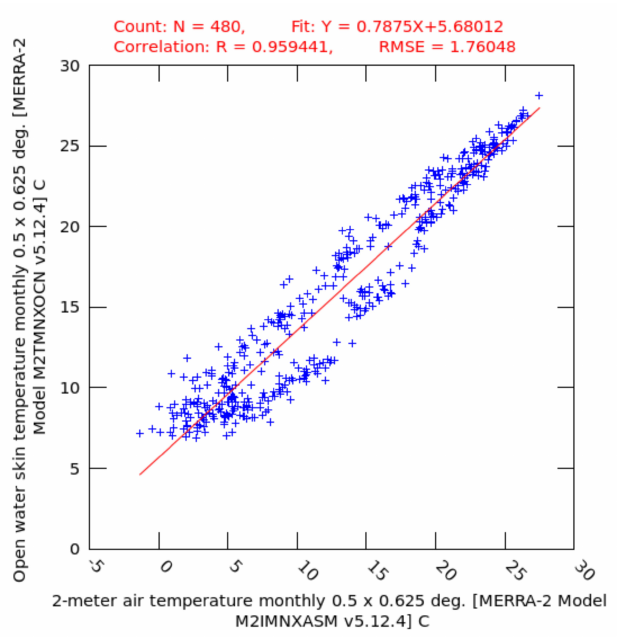
Figure 8. Relationship between the monthly mean 2 − meter air temperature and the monthly mean SST for